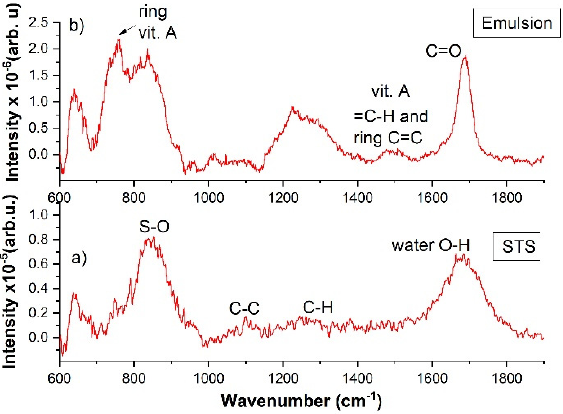
Figure 7. Raman spectra excited with pulsed laser beam at 266 nm, 40 mJ / per pulse for ( a ) 10% STS in water solution, ( b ) O / W emulsion (50% oily vitamin A ( v / v ) with the oil phase 2% vitamin A in sunflower oil, and the water phase 10% STS in ultrapure water).